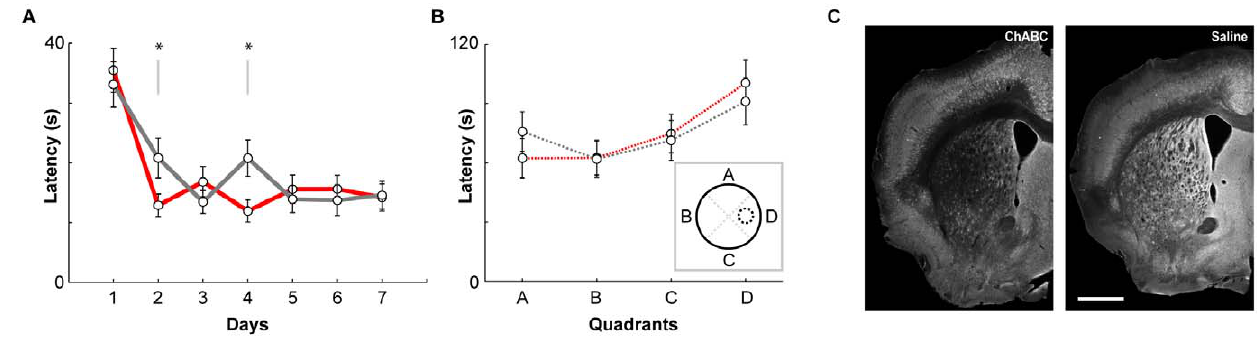
Figure 4. Removal of striatal PNNs improves Morris water maze acquisition. A significant interaction between treatment Group and training Days was observed in terms of latency to goal (Repeated measures ANOVA, group versus days interaction, P =0.013) (A). Closer analysis revealed that ChABC treated animals (red) took significantly shorter amounts of time to find the submerged platform on Days 2 and 4 (ANOVA, P , 0.05). (B) Although both ChABC (red dotted) and vehicle (grey dotted) treated groups exhibited a preference for the quadrant that previously contained the submerged platform (Quadrant D; inset), no significant difference was observed between the two groups. (C) Sample hemispheres of ChABC (left) and saline (right) treated striatum from animals that had completed behavioral testing. PNNs remained digested even after two weeks of training. Scale bar: 1 mm.